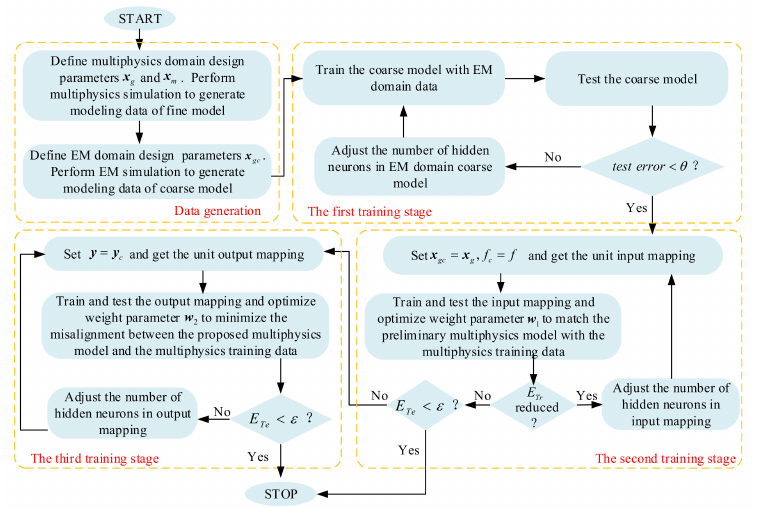
Figure 2. Flowchart of the proposed Neuro-SM multiphysics model training and test